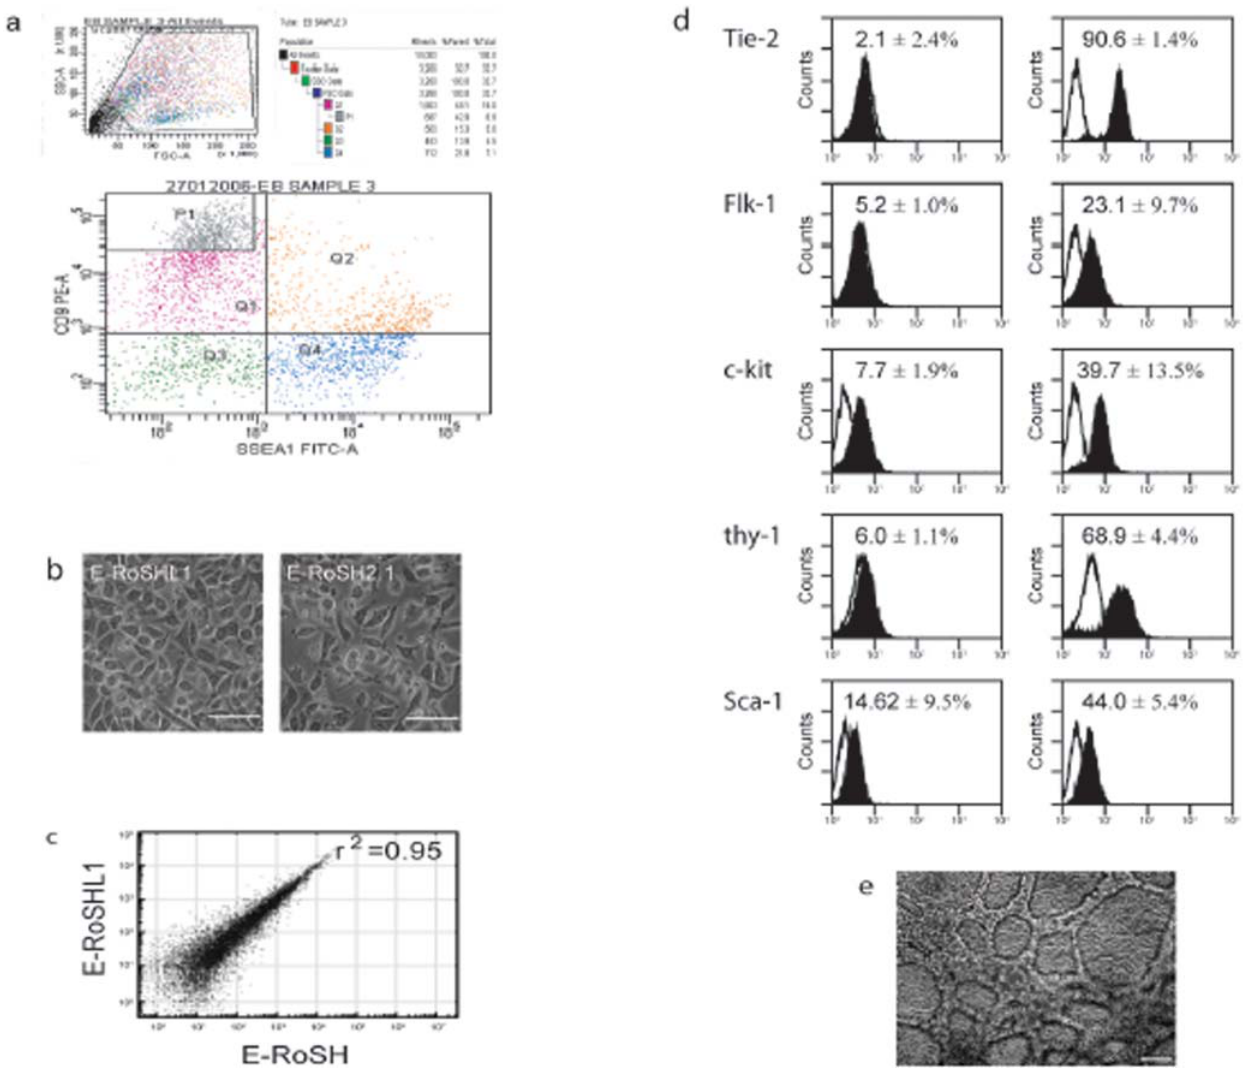
Figure 5. Derivation of E-RoSHL1 cell line from CD9 hi , SSEA1 lo cell population in EB culture. a) One week after plating 5 day old EBs on gelatinized culture plates, the cells were harvested, labelled with anti-CD9 antibody conjugated with PE and anti-SSE4-1 antibody conjugated with FITC, and sorted. CD9 hi , SSEA1 lo cells in the P1 quadrant were selected as putative RoSH cells and plated on gelationized feeder plate; b) Morphology of semi- confluent E-RoSHL1 and E-RoSH2.1. Bar represent 15 m m; c) Pairwise comparison of global gene expression between E-RoSHL1 and E-RoSH cells. Global gene expression analysis were performed by hybridizing total RNA from two biological samples each of E-RoSHL1, E-RoSH2.1 and E-RoSH3.2 with Illumina BeadArray containing about 24,000 unique features; d) Flow cytometry analysis of E-RoSHL1 cells for endothelial markers before (righ panels) and 60 hours after (left panels) induction of differentiation by plating cells on matrigel. Nonspecific fluorescence was determined by incubation of similar cell aliquots with isotype-matched mouse monoclonal antibodies or with secondary antibody alone; e) Morphology of E-RoSHL1 culture one week after induction of differentiation by plating on matrigel. Bar represents 50 m m.